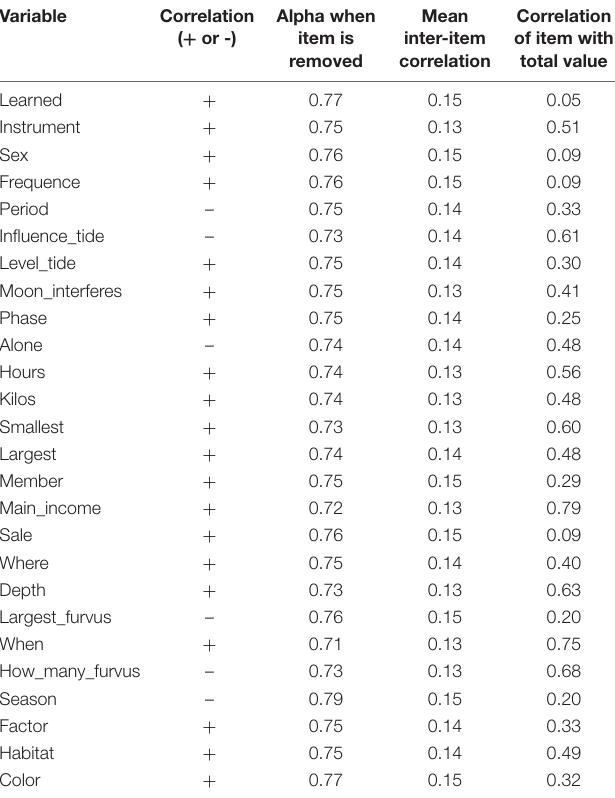
TABLE 4 | Cronbach’s alpha statistics for the questionnaire applied to the fishers of the “eastern octopus” ( n = 50) along the Brazilian coast (standardized alpha =